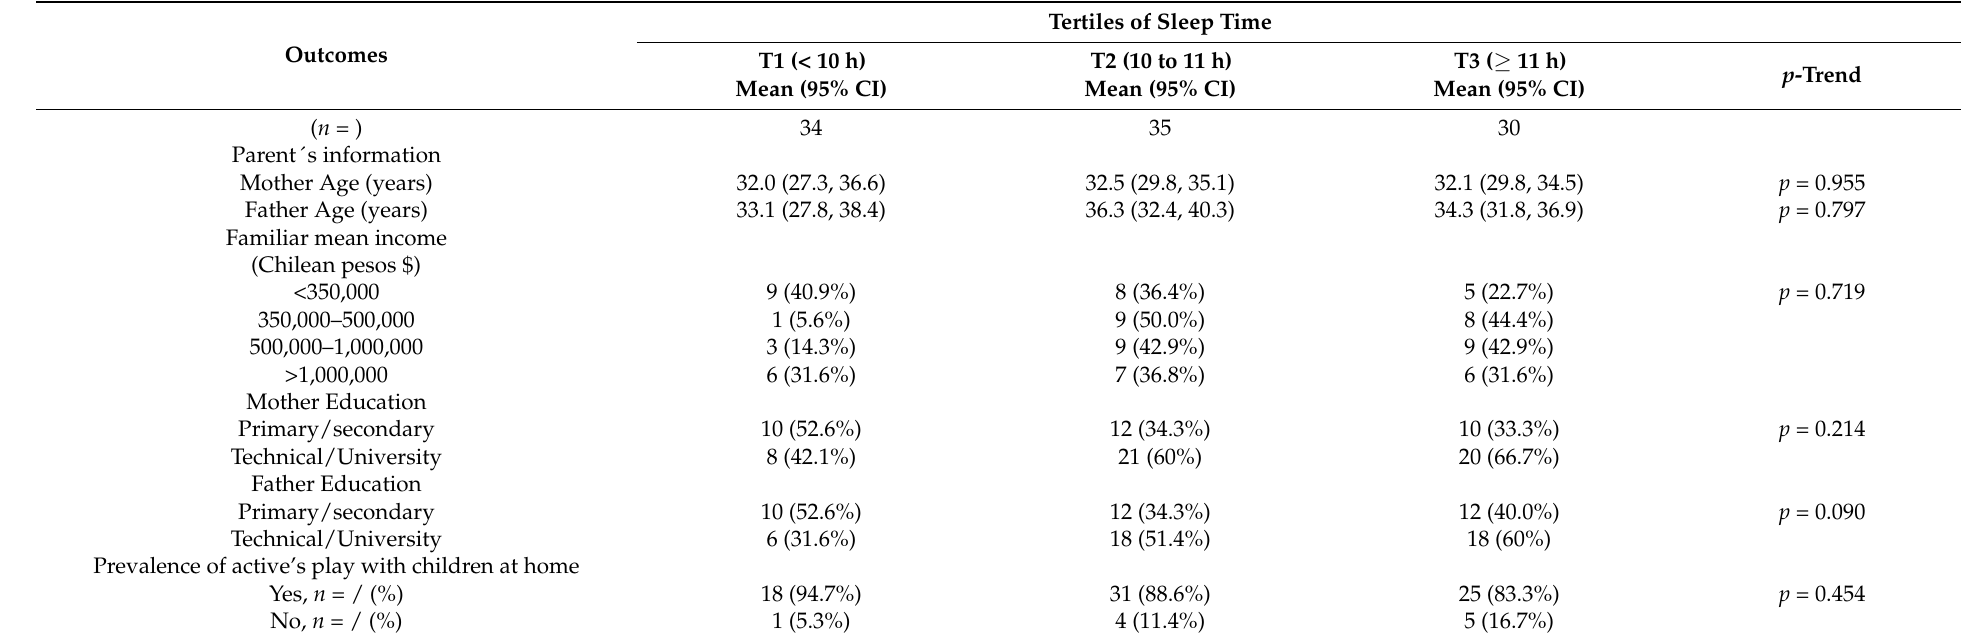
Table 1. Parents’ socio-demographic and health-related preschooler’s characteristics of the